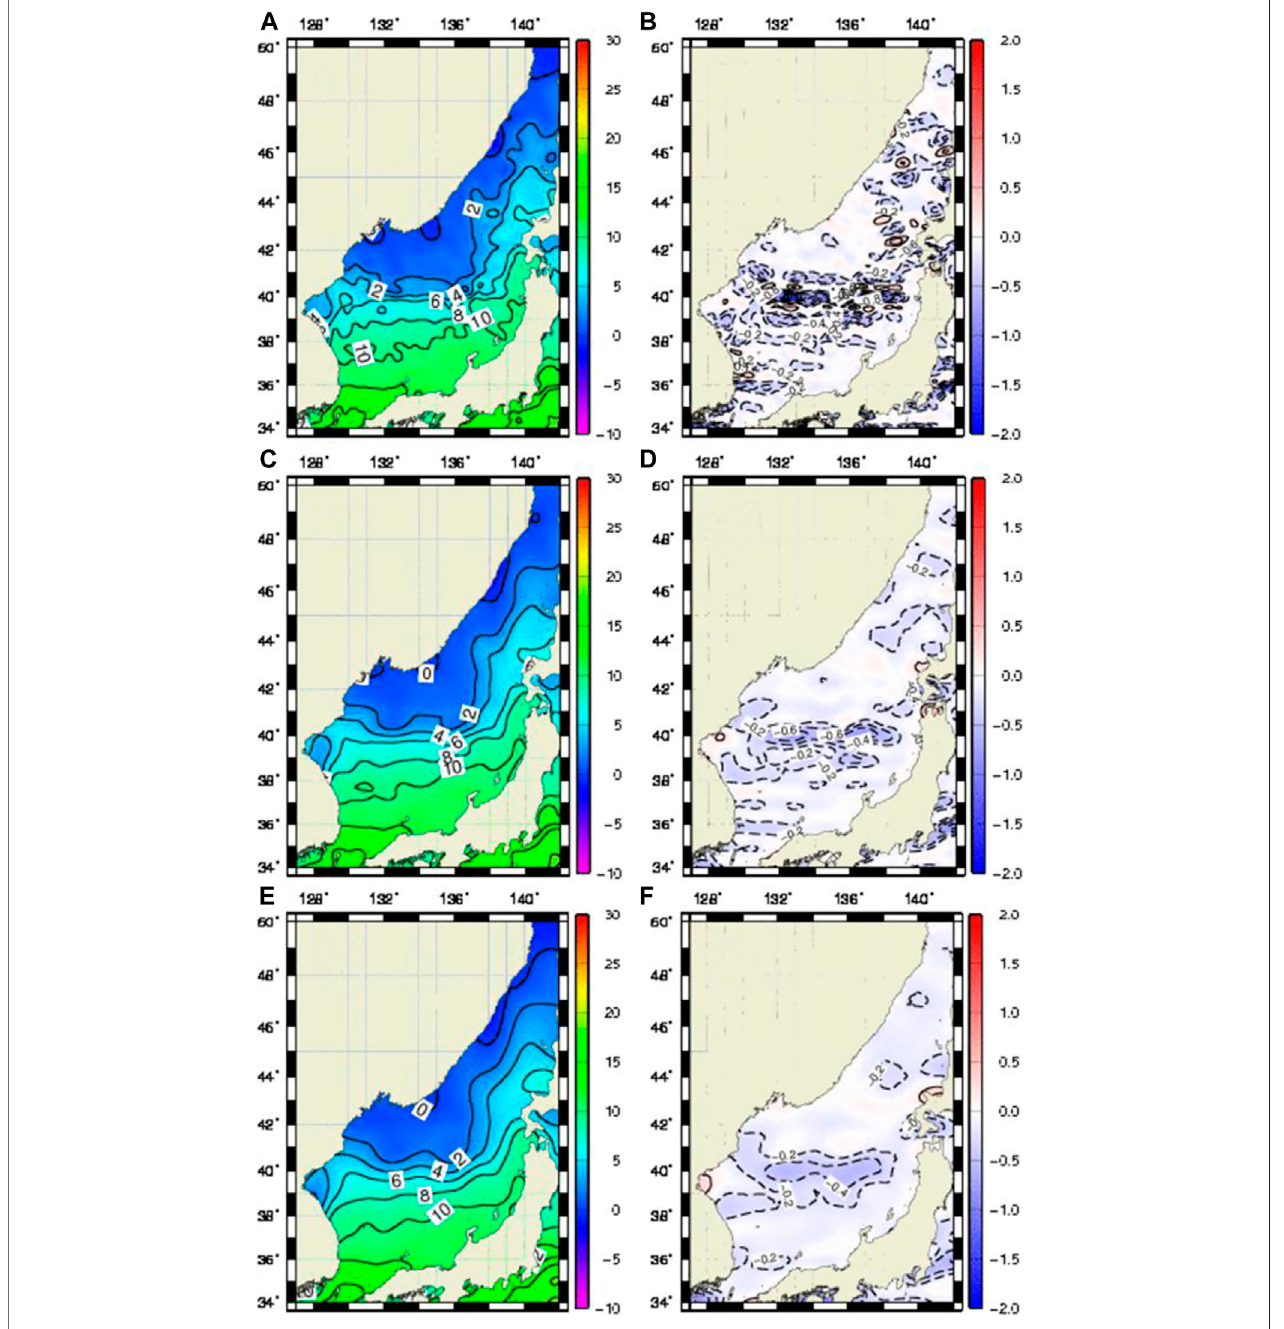
FIGURE 7 | The same as Figure 3 except for three different in fl uence radii. (A, B) The in fl uence radius applied were 111 km, (C, D) 211 km, and (E, F) 311 km, respectively.